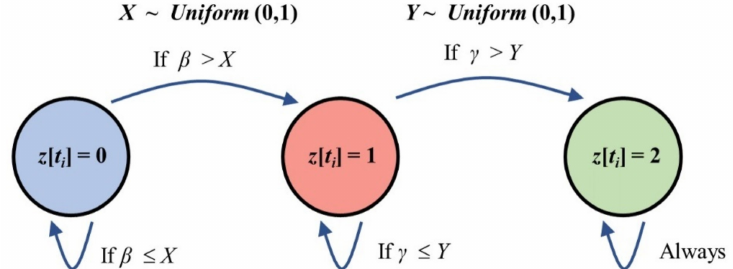
Figure 3. Conceptual layout for status transition of nodes based on the Monte Carlo method. Status transition is determined by comparing the epidemic parameters ( β , γ ) to random numbers ( X , Y ) extracted from a uniform